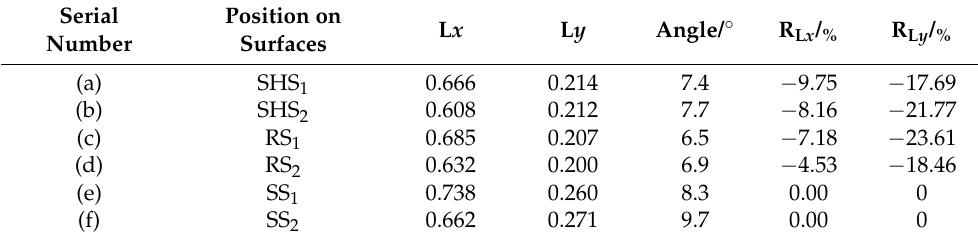
Table 1. Characteristic parameters of spatial correlation